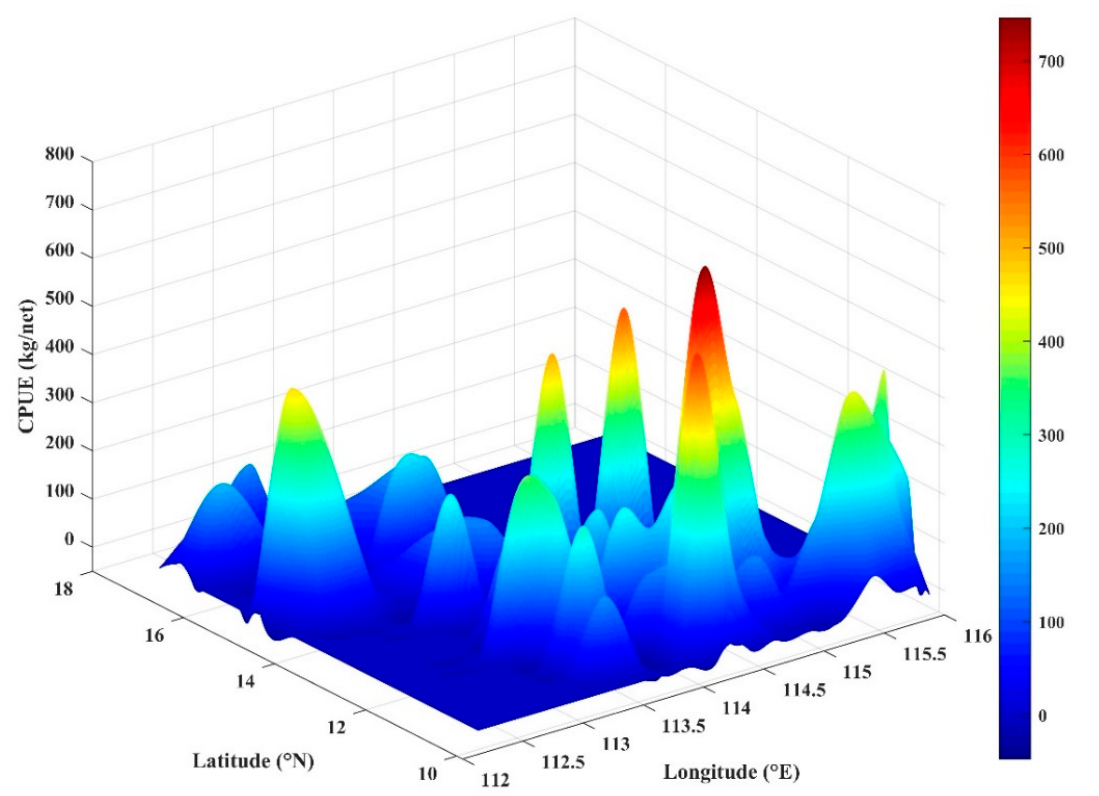
Figure 8. Spatial variation of catch per unit effort (CPUE) of S. oualaniensis.